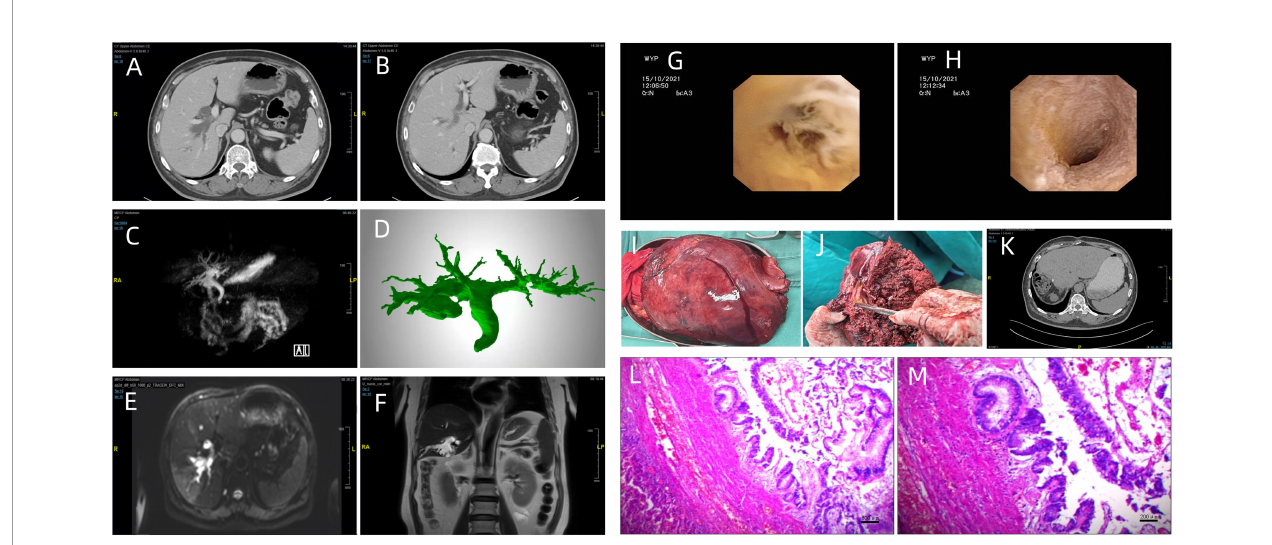
FIGURE 2 | (A,B) Enhanced computedtomography demonstrated thickening of the distalcommon bileduct wall, luminalstenosis, dilatation of extrahepatic and intrahepaticbileduct, especially more evident in the right lobeofliver; (C) (MRCP) and (D) (CT threedimensional reconstruction)revealed the dilatation of extrahepaticand intrahepaticbileduct; (E) (diffusion-weighted image) The bileduct showed high intensity; (F) (coronal view)showed the dilatation ofintrahepaticbileduct in the right lobeof liver;Intraoperative cholangioscopy revealed the common bileduct wall was fullof the white fl occulus (G) andrough (H) ; Grossly, the lumen of intrahepatic bileduct was full of yellow,gelatinous, sticky mucousmasses (I, J) ; abdominalcomputed tomography (CT) showed homogeneousliver parenchymawithout bileduct dilation (K) ; Microscopically, Intraductal papillary neoplasm of thebileduct(IPNB)with low-gradeintraepithelial neoplasia, focal high-grade intraepithelial neoplasia; A large amount of lymphocytes aggregated portal area with extensive bileduct proliferation ( L : magni fi cation, x40 and M : magni fi cation, x100; hematoxylin and eosin